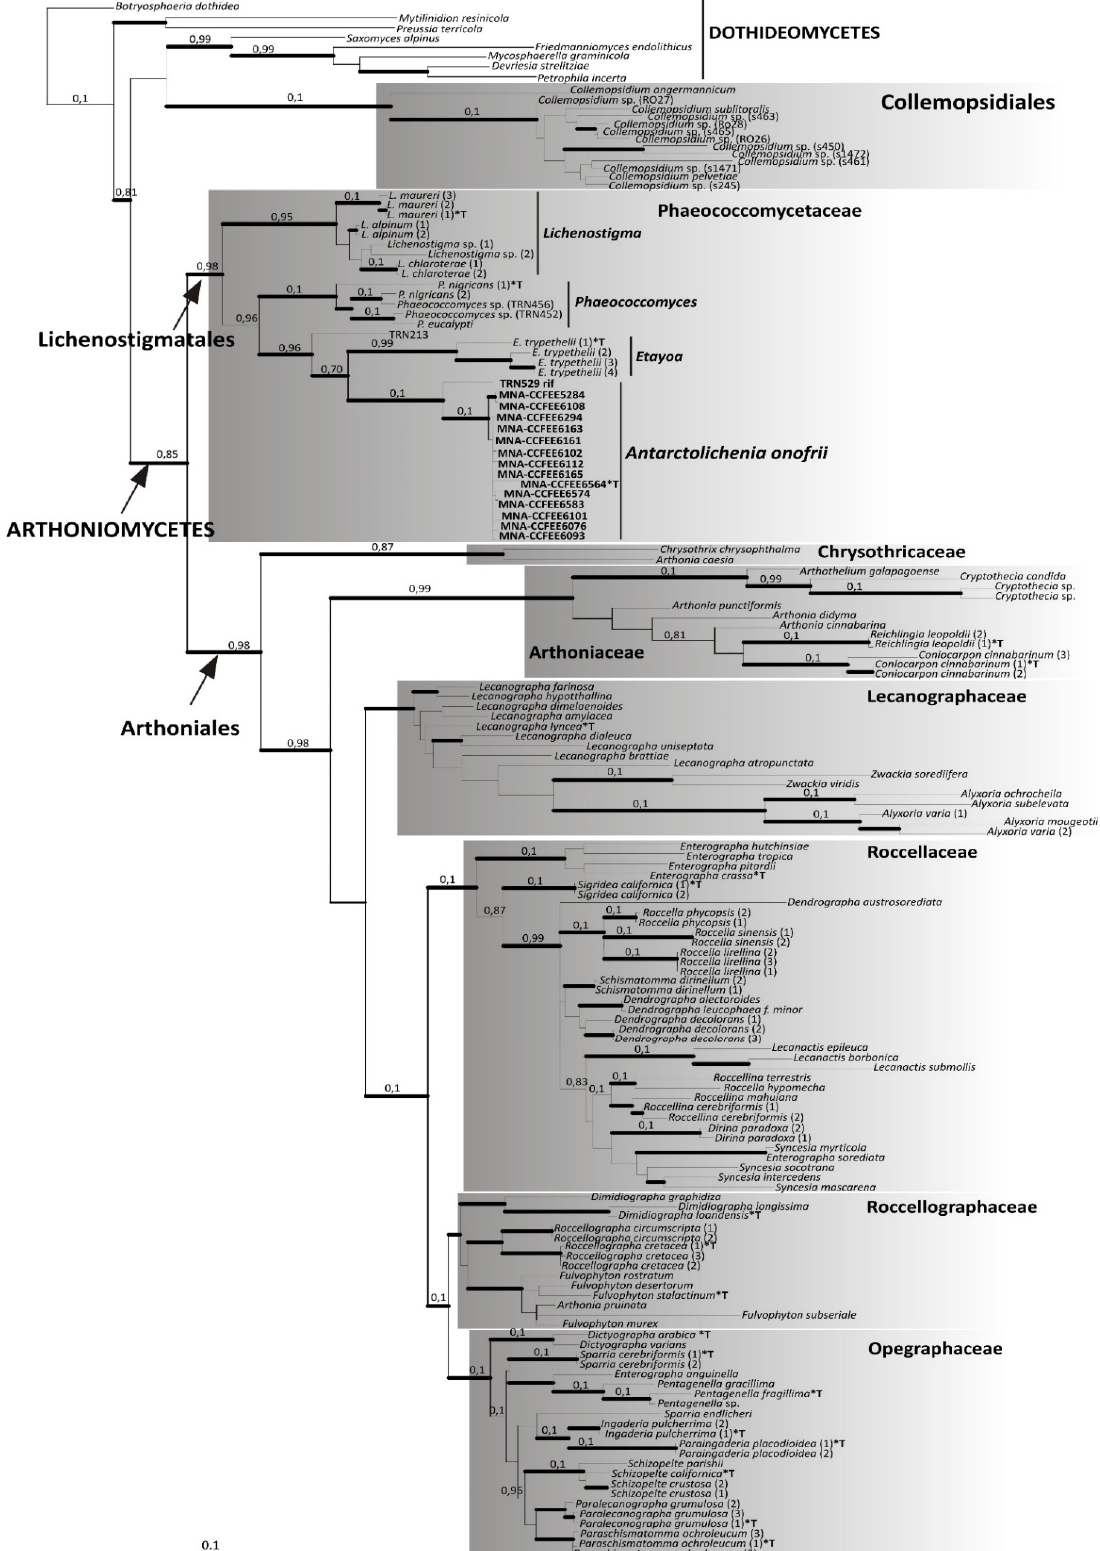
Figure 2. Phylogenetic analysis based on the combined nucLSU and nucSSU sequences of Arthoniomycetes , using Doth- ideomycetes as an outgroup. The data for taxa retrieved from GenBank are reported in the Supplementary Table S1